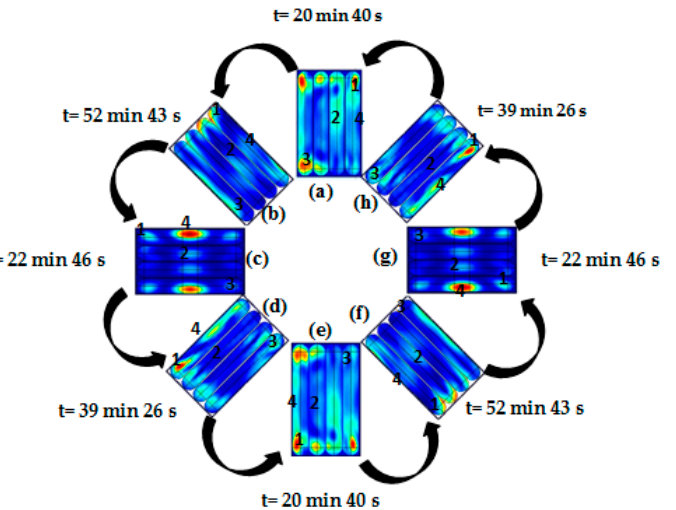
Figure 10. Thermal simulation of rotating ready-to-eat sausage under microwave heating at angle position of ( a ) 0°, ( b ) 45°, ( c ) 90°, ( d ) 135°, ( e ) 180°, ( f ) 225°, ( g ) 270°, and ( h ) 315°, simulated by using COMSOL.